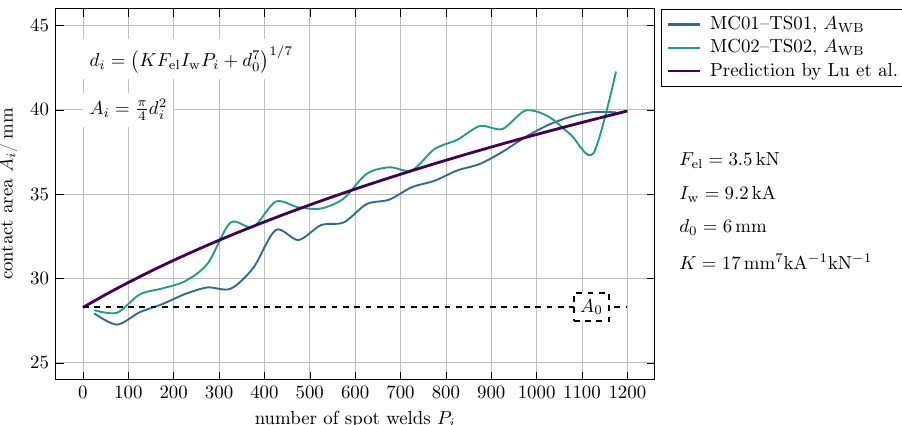
Figure 20. Comparison of A WB of MC01 with prediction model of Lu et